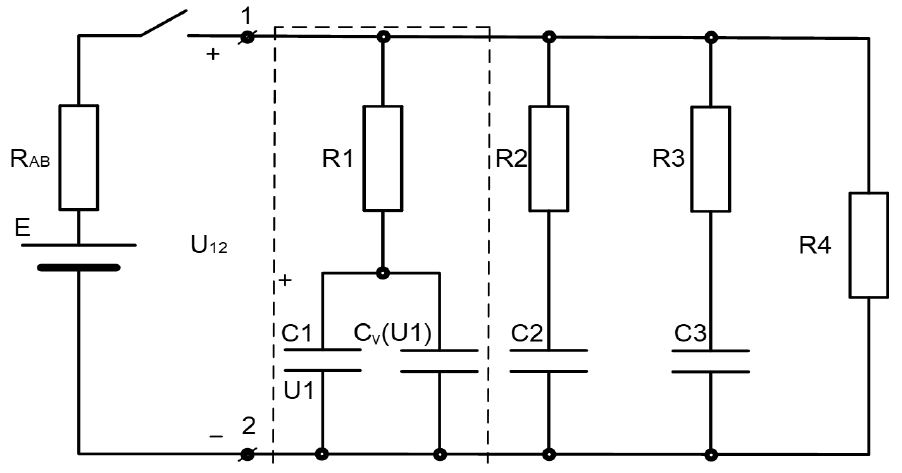
Figure 1. The scheme of replacement of SC.